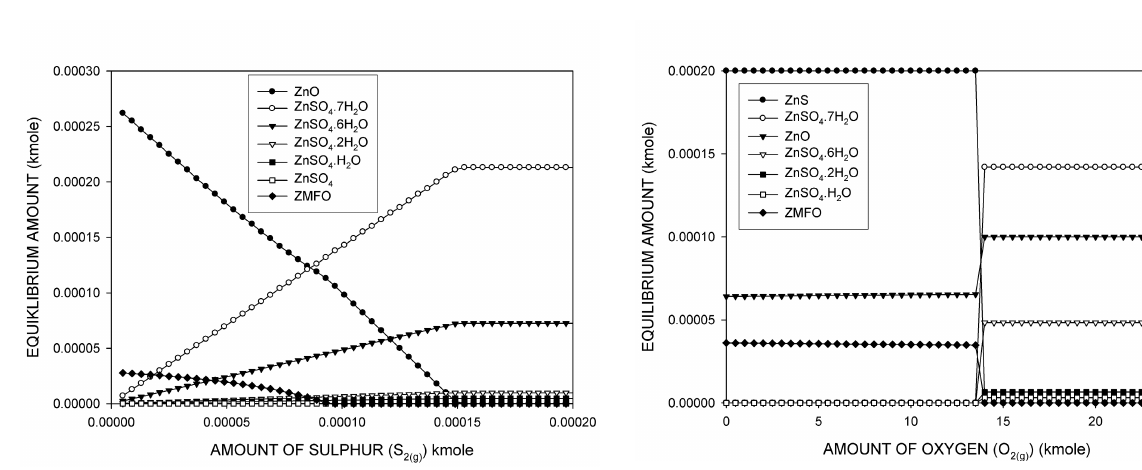
Figure 10(d). Effect of amount of oxygen on the equilib- rium amounts of the zinc-containing species at 298 K for the Zn-Fe-Mn-O-C-H-S system.